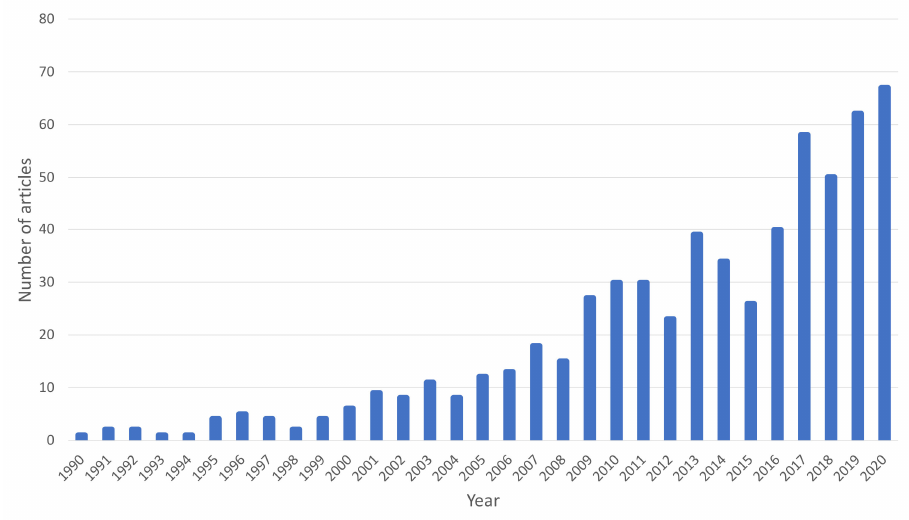
Figure 2. Number of scientific articles on fruit vinegar published per year (Source: Scopus).